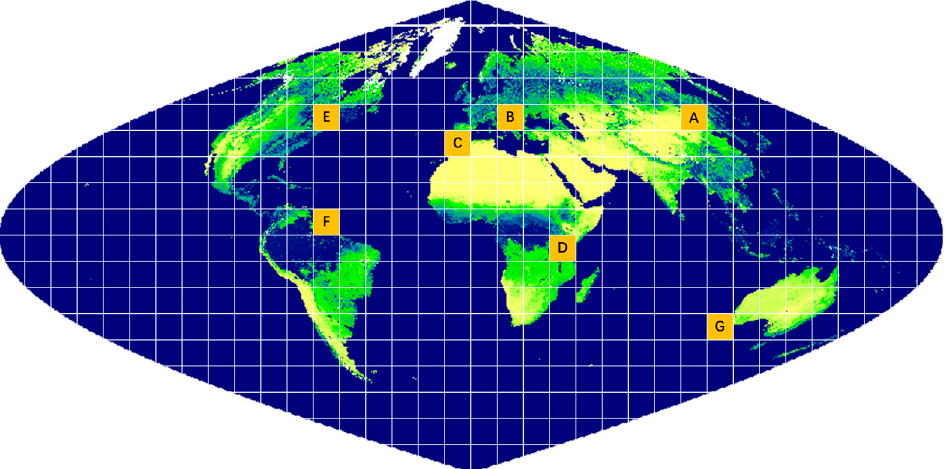
Figure 3. Seven tiles selected as validation regions. A: h26v04, B: h19v04, C: h17v05, D: h21v09, E: h12v04, F: h12v08, G: h27v12.